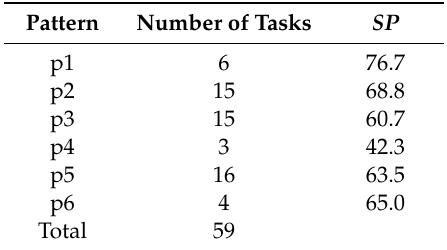
Table 1. Number of tasks classified by pattern and task-specific SP See article supplement Table S1 for details.